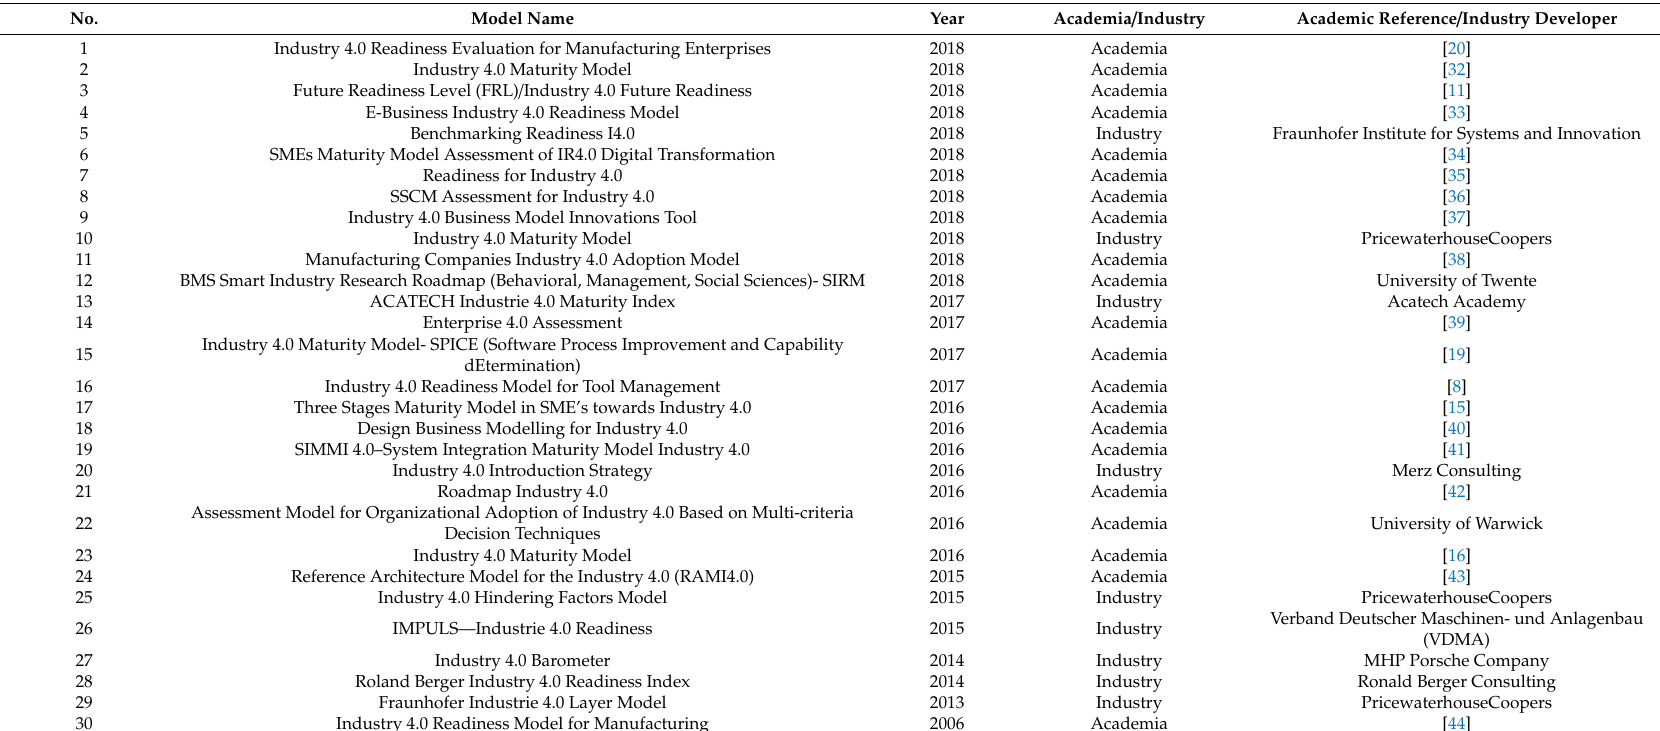
Table 3. List of Industry 4.0 Readiness